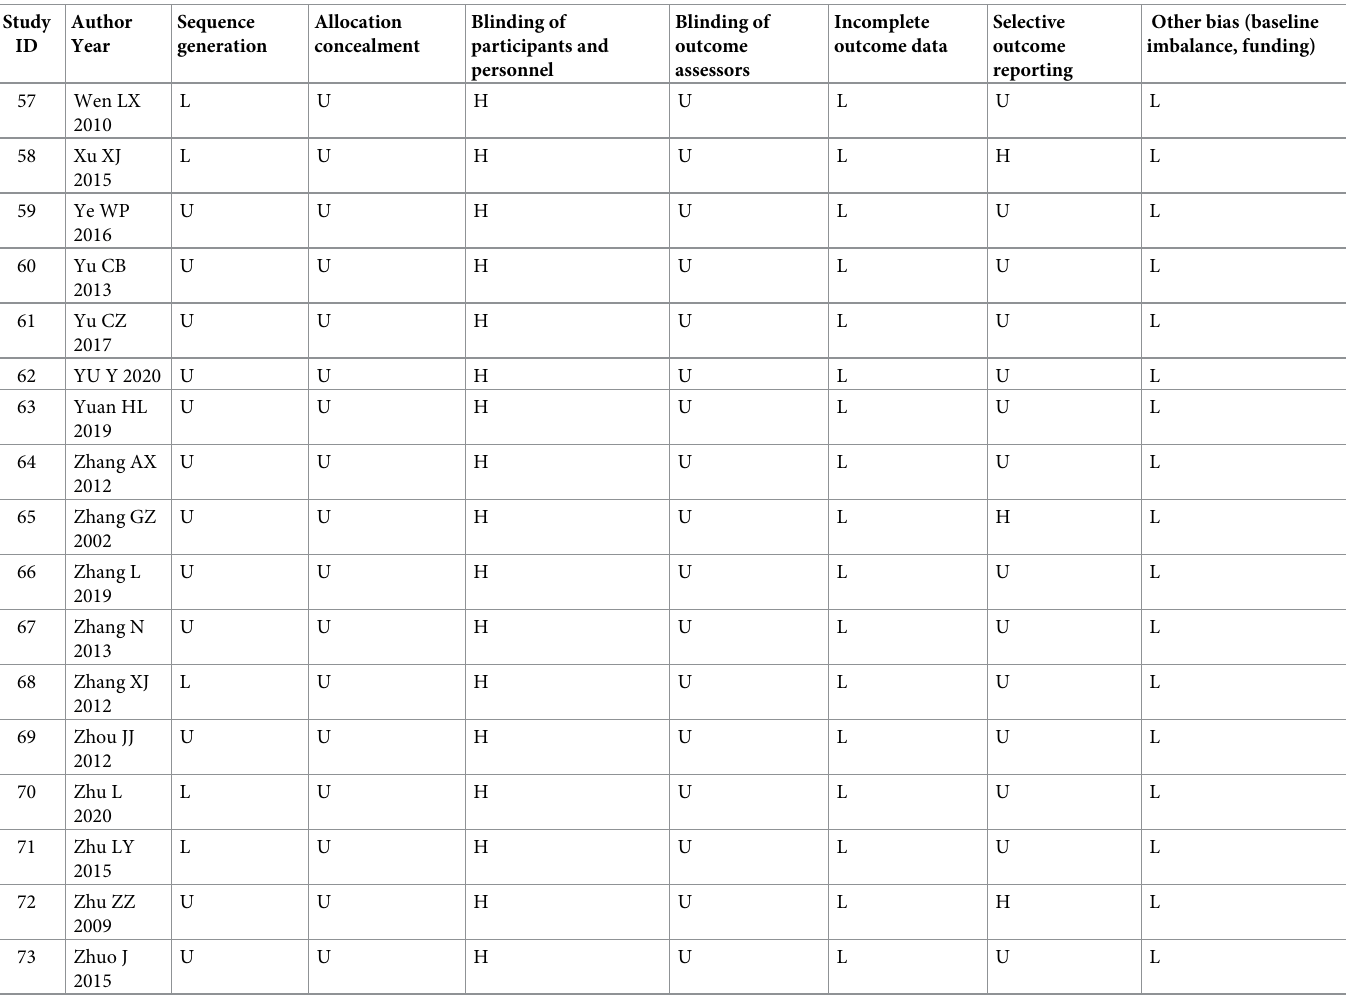
outlier study [57] produced results similar to the overall meta-analysis (MD -0.85 [-0.95, -0.75]; I 2 = 74.1% P = 0.00). Egger’s test demonstrated there was evidence of publication bias ( t = 2.21, P = 0.03), funnel plot also showed asymmetry (S3 Fig in S1 File). Meta-analysis of studies assessed as low risk of bias for sequence generation produced a similar result to the overall results with reduced heterogeneity (29 RCTs, 2,576 participants, MD -0.82 [-0.95, -0.69]; I 2 = 61.8%, P = 0.00). Subgroup analyses based on comparator drug class, patient age groups, baseline levels of FBG, TCM syndrome differentiation, treatment duration, disease duration and baseline levels of BMI all showed significant differences between groups (Table 3). pants assessed the effects of CHM plus hypoglycaemic agents compared to hypoglycaemic agents alone [18–22, 25–33, 35–50, 52–54, 56–59, 61–67, 69–71, 73–75, 77–80, 82–86, 88–90]. Treatment duration ranged from 4 to 25